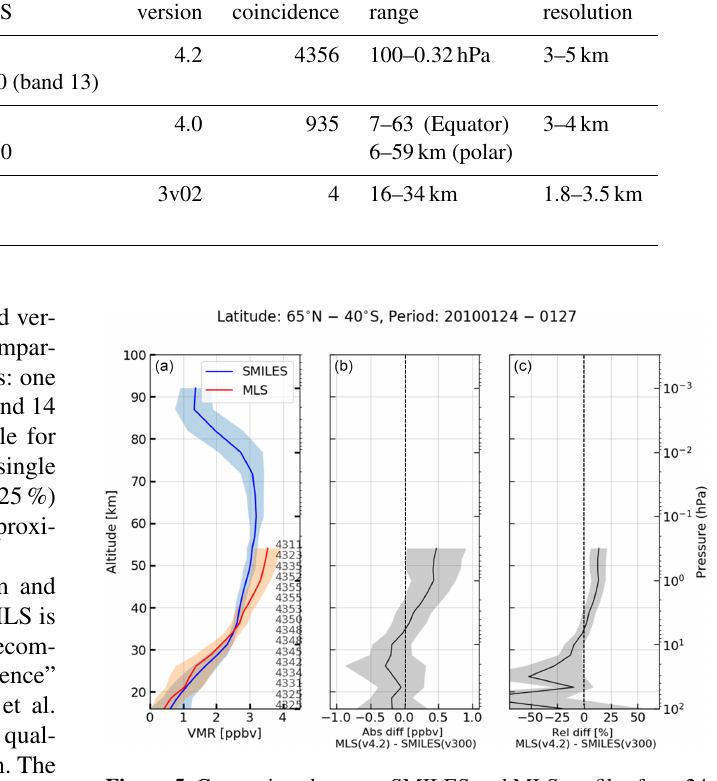
Table 3. Characteristics of instruments and datasets used in the comparison. Instrument